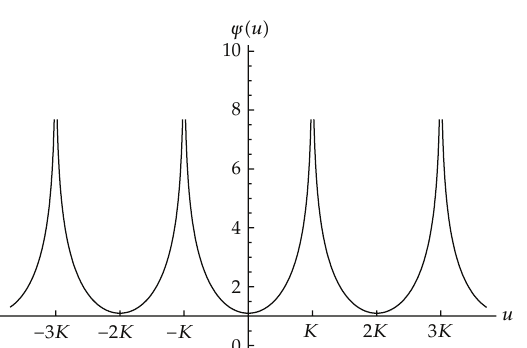
Figure 2: The solution ψ (cid:3) u (cid:4) (cid:8) ln (cid:3)(cid:3) dn (cid:3) u,k (cid:4) (cid:7) k (cid:2) (cid:4) / (cid:3) dn (cid:3) u,k (cid:4) − k (cid:2) (cid:4)(cid:4) for the Poisson Boltzmann equation. The parameters are k 2 (cid:8) 0 . 75 and K (cid:8) 2 . 156.